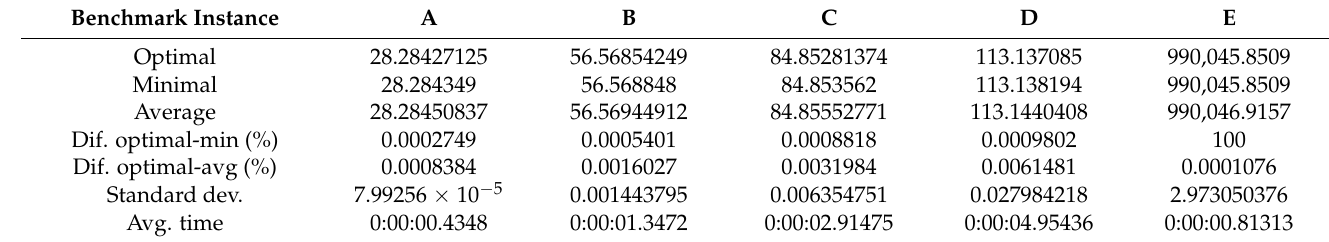
Table 9. Calculations